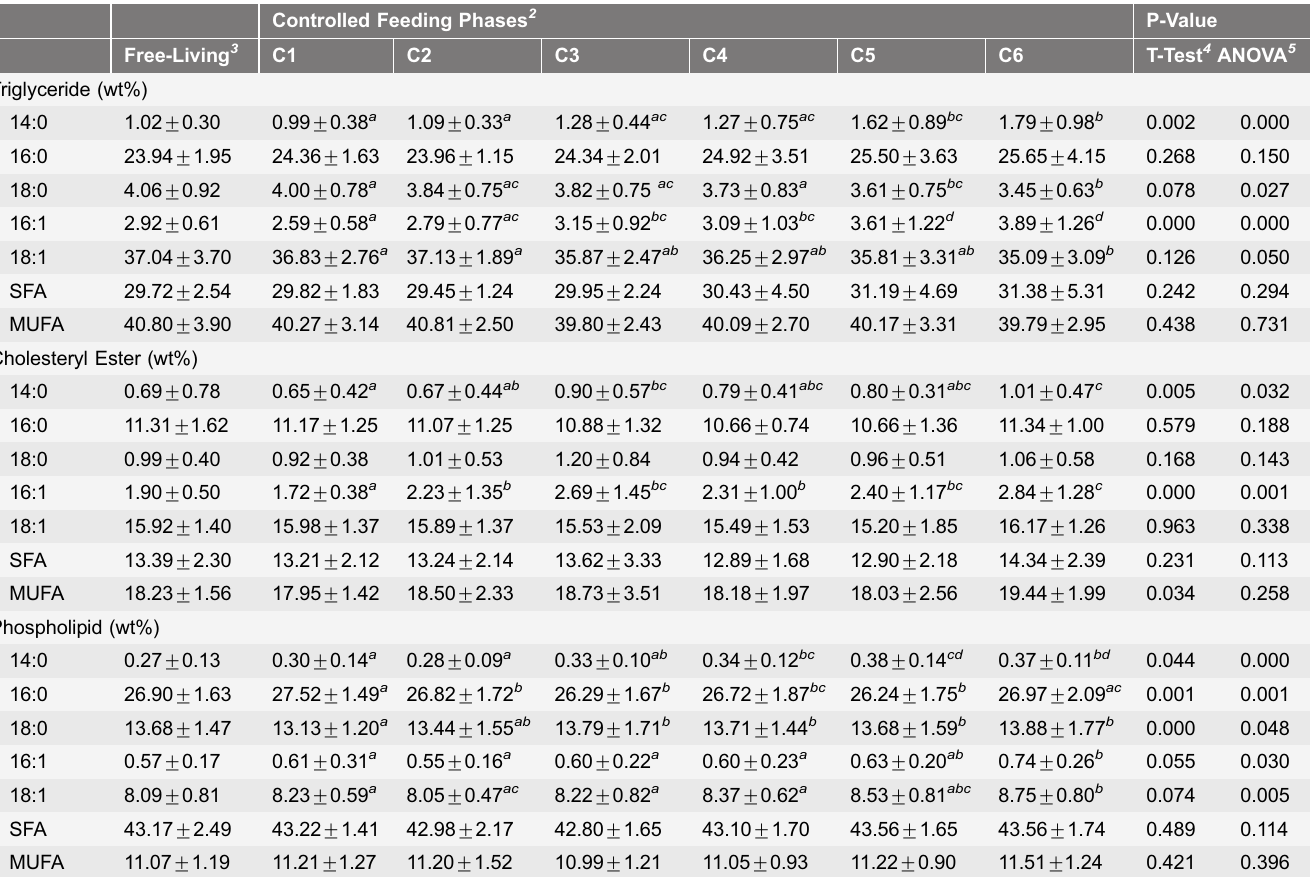
Table 3. Plasma fatty acid responses 1